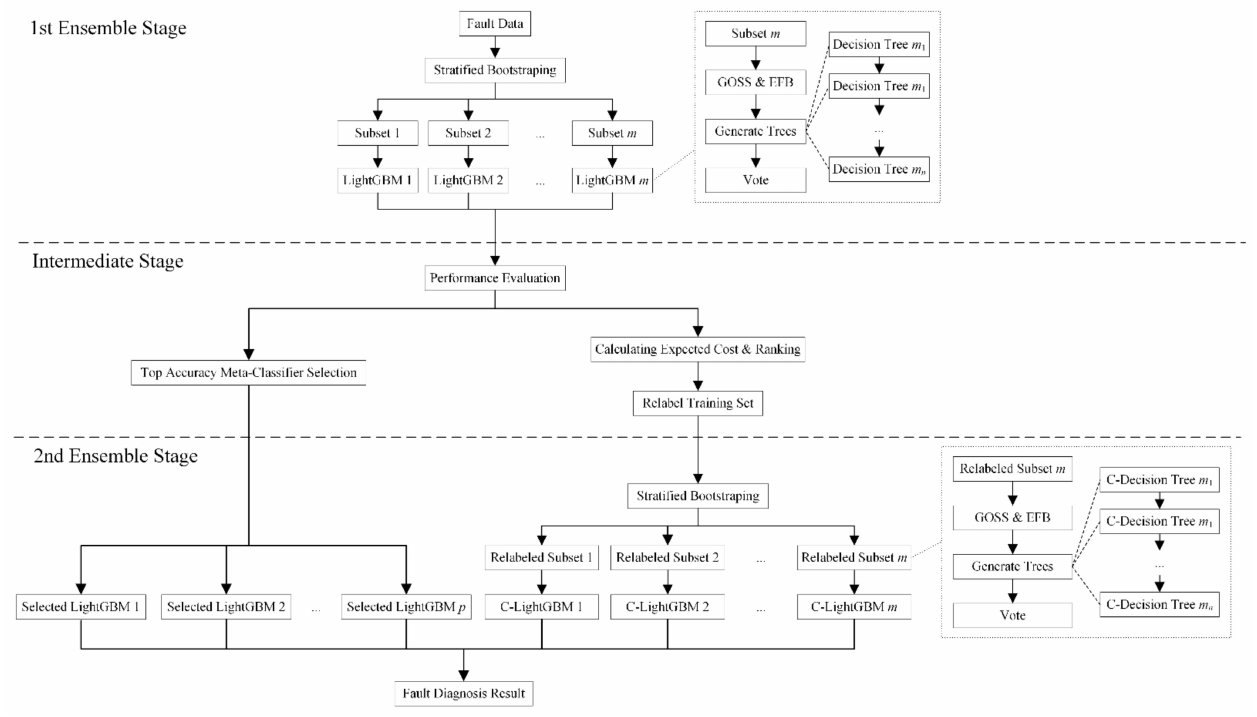
Figure 1. The basic workflow of the proposed two-step ensemble cost-sensitive diagnosis model